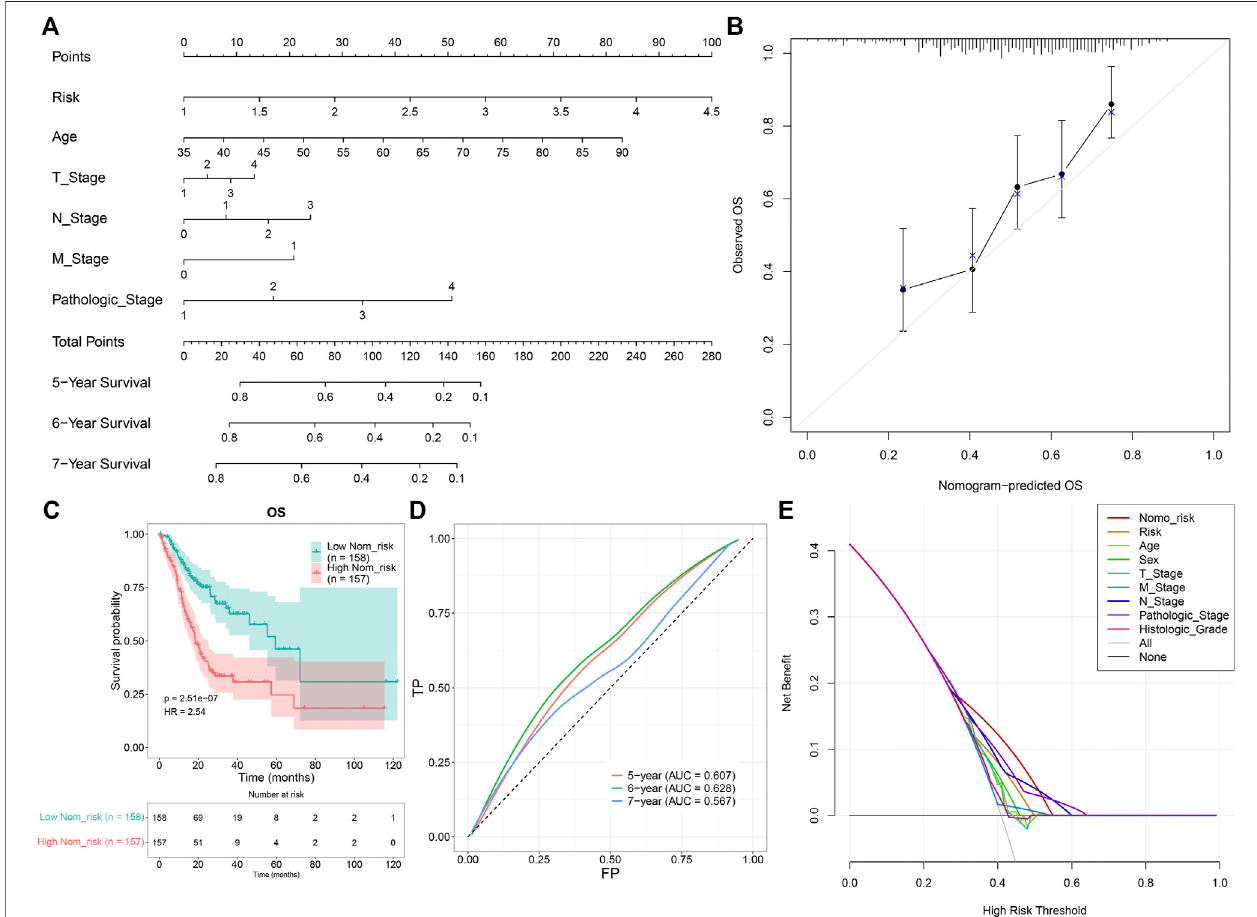
FIGURE4| DevelopmentofaprognosticnomogramforGCpatients. (A) NomogrammodelintegratingtheTNF α -derived genesignature,age,Tstage,Nstage, M stage, and pathological stage for prediction of GC patients ’ 5-, 6-, and 7-year OS probabilities. (B) Calibration curves for this nomogram-predicted and observed OS outcomes. The 45-degree line meant the ideal prediction. (C) Kaplan – Meier curves of OS for high- and low-risk GC patients. (D) ROC curves for the nomogram in the prediction of 5-, 6-, and 7-year OS probabilities. (E) Decision curve analysis curves of the nomogram for OS outcomes.